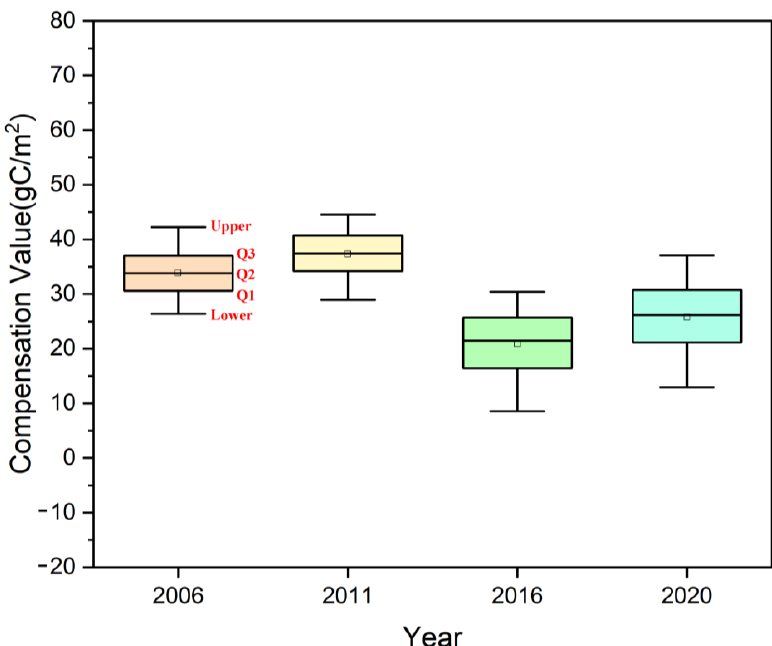
Figure 4. Boxplots of the NPP differences of the four study years in the contrast area.